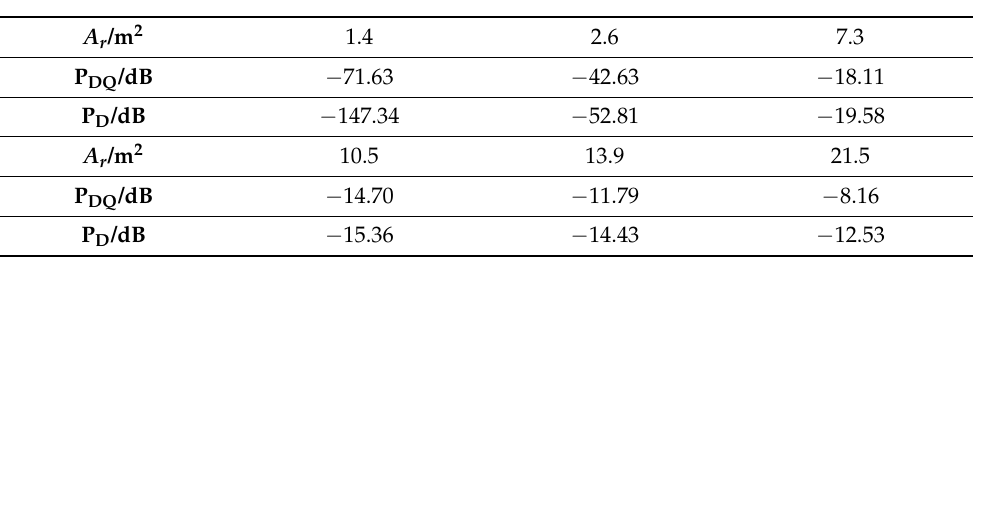
Table 2. Average detection probability of quantum and conventional radar at different aperture